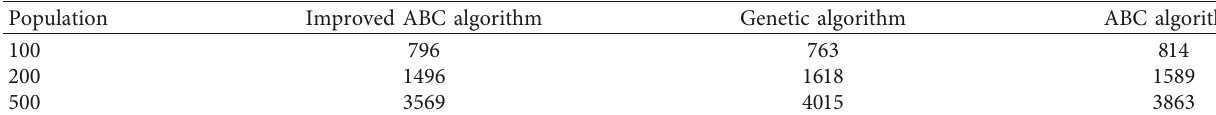
Table 8: Performance comparison between improved ABC algorithm and others.